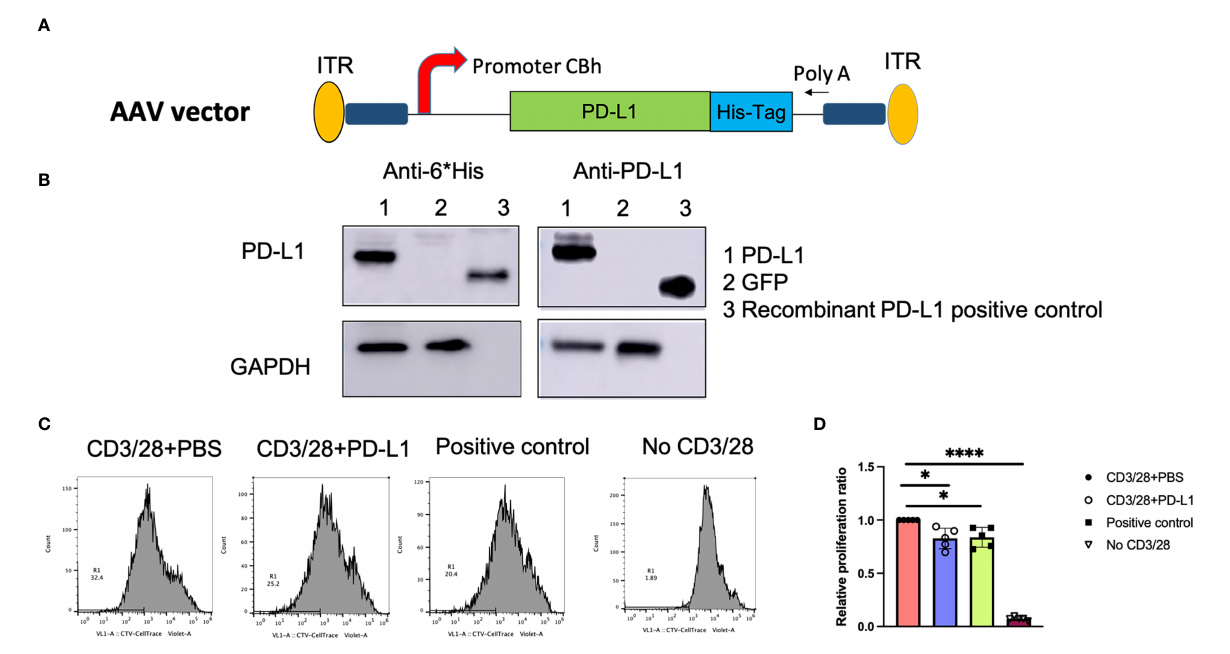
FIGURE 1 PD-L1 gene expression and function in vitro . (A) , Schematic diagram of the AAV/PD ‐ L1 cassette. (B) , Western blot analysis for PD ‐ L1 protein expression. After transfection of pTR/CBh-PD-L1 or pTR/CBh-GFP into HEK-293 cell lines, 48h later, the supernatant and cell lysate were collected for PD-L1 expression by western blot with antibodies against either His tag or PD-L1. Data shown is the representative of 5 independent experiments. (C) , T cell proliferation. Puri fi ed splenic T cells were stained with CellTrace Violet dye, then co-cultured with PBS, PD-L1 in the presence of anti-CD3/anti-CD28 for 72h. The proliferation of positively stained cells was analyzed with fl ow cytometry. Data shown is representative of 5 independent experiments. (D) , Summary data of T cell proliferation. The result was normalized to T cell proliferation rate in the group with CD3/ 28+PBS (n=5). Mean values are shown with standard derivation. Data was analyzed using one-way ANOVA followed by Bonferroni multiple comparison test for comparisons. *, p < 0.05, ****, p <